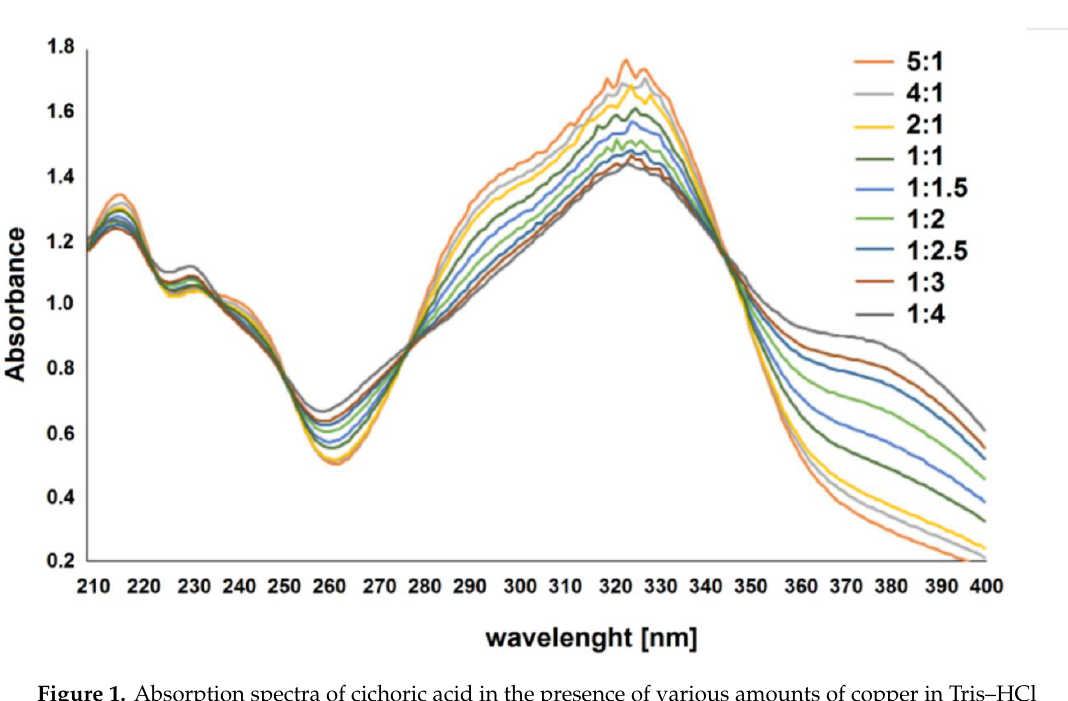
Figure 1. Absorption spectra of cichoric acid in the presence of various amounts of copper in Tris– HCl buffer pH 7.2 (different types of lines are labeled with a molar ratio of cichoric acid:metal 5:1– 1:5).